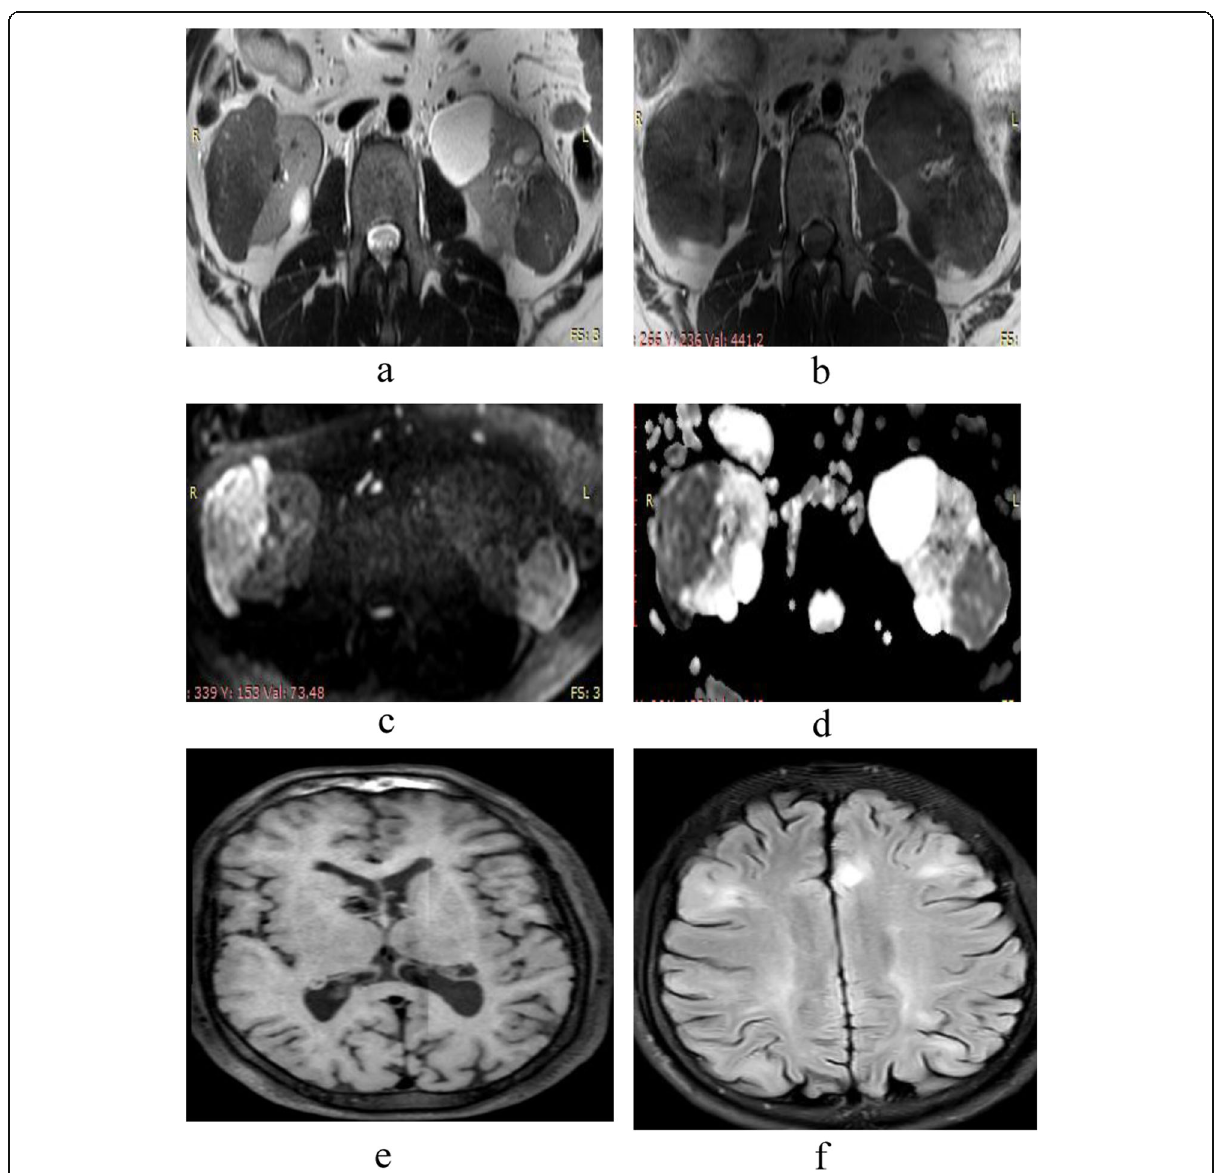
Fig. 11 A 32-year-old male known to have tuberous sclerosis complex a - d MRI showing bilateral renal lipid poor AML; a T2WI showing bilateral hypointense renal masses, b T1WI hypointense, c , d DWI with ADC showing restricted diffusion; ADC averaging 0.8-1 × 10 − 3 mm 2 /s, e , f MRI brain of the same patient showing subependymal tubers and white matter